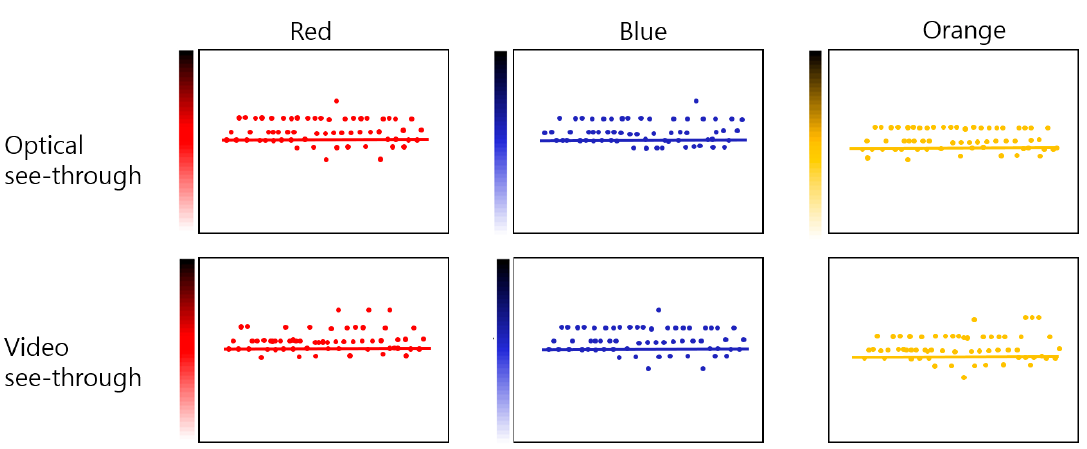
Figure 15. Results regarding color perception. The subjects overestimated the colors when using two MR devices (video and optical).